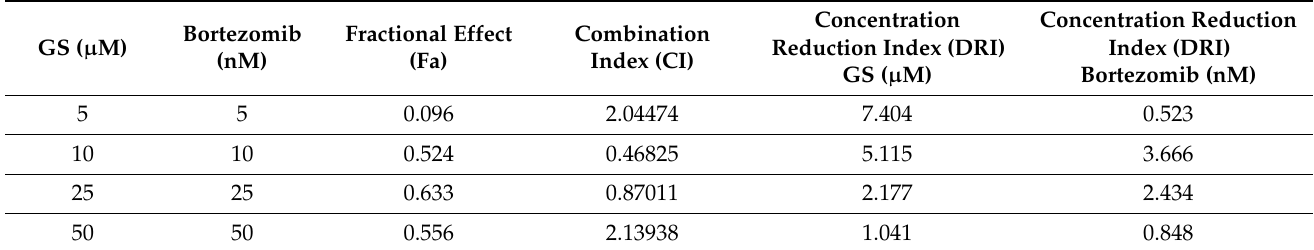
Figure 7. Calculating the synergistic concentrations required for a combination treatment with GS and BTZ. U266 cells were treated with 5, 10, 25, and 50 µM of GS or 5,10, 25, and 50 nM of BTZ alone or in different combinations to calculate the synergistic apoptotic response of GS and BTZ at 48 h. The concentration and fraction effect ( A , B ) graphs were created using CalcuSyn software. CI were calculated by employing Chou and Talalay’s methodology [41]. Table 1. Combination Index calculation using Chou and Talalay method in U266 cell line.